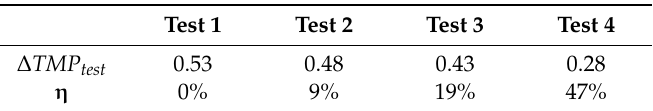
Table 4. Comparison of ∆ TMP and effectiveness ( 𝝶 ) of backpulses (test 2) and backwashings (test 3 and test 4) as flux maintenance strategies.